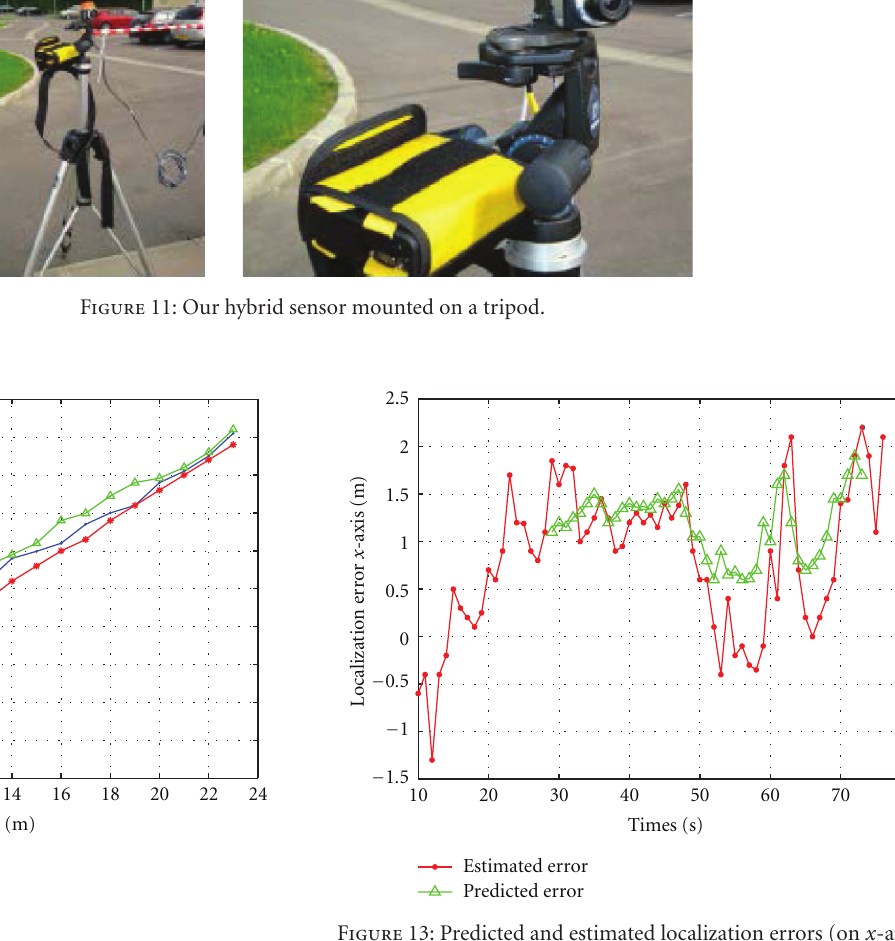
Figure 12: The straight line test: reference position versus camera position versus GPS position.